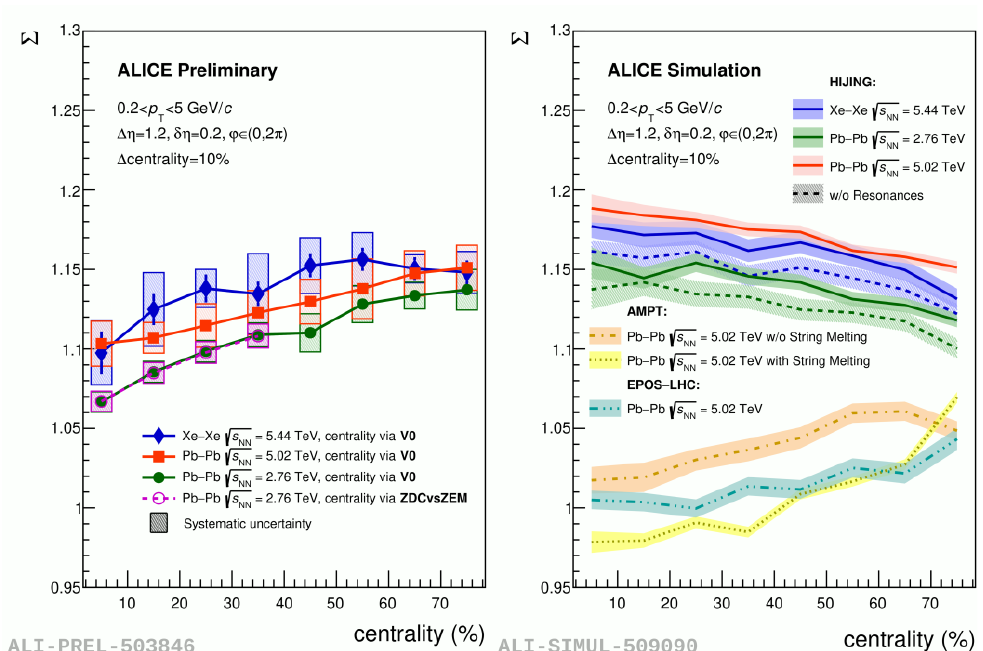
Figure 2: Centrality dependence of strongly intensive quantity Σ obtained for Pb–Pb col- √ s NN = 2 . 76 and 5 . 02 TeV and Xe–Xe collisions at lisions at are presented for a fixed value of the pseudorapidity gap ∆ η = 1 . 2. Experimental data pre- sented on the left panel are compared with the results for MC HIJING, EPOS, and AMPT simulations (right